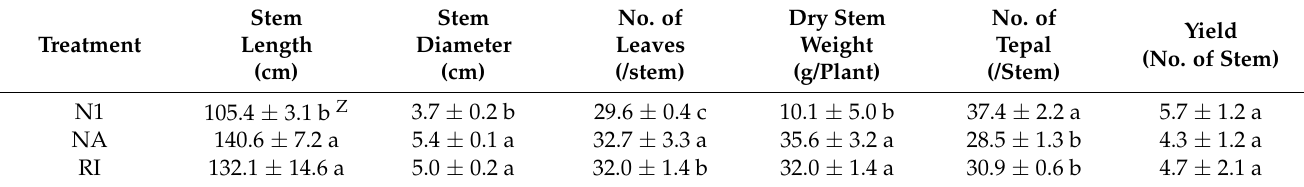
Z Values followed by different letters within a column are significantly different (DMRT, p < 0.05; n =